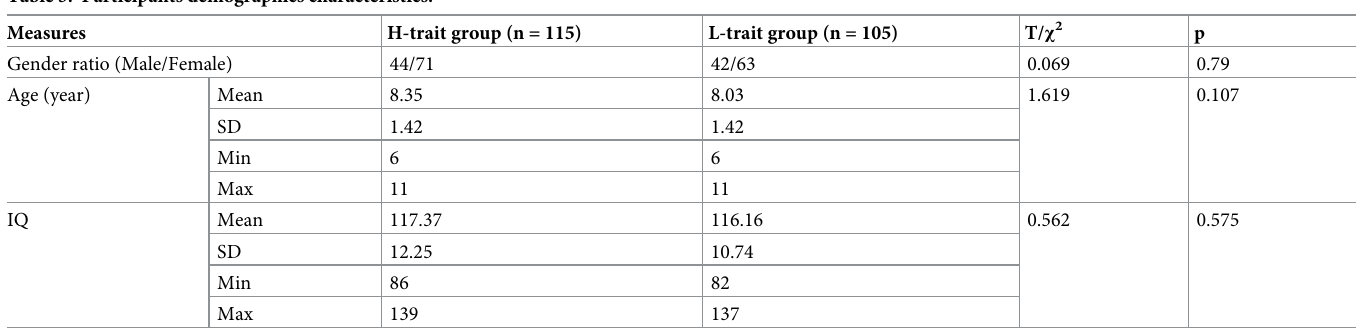
Table 3. Participants demographics